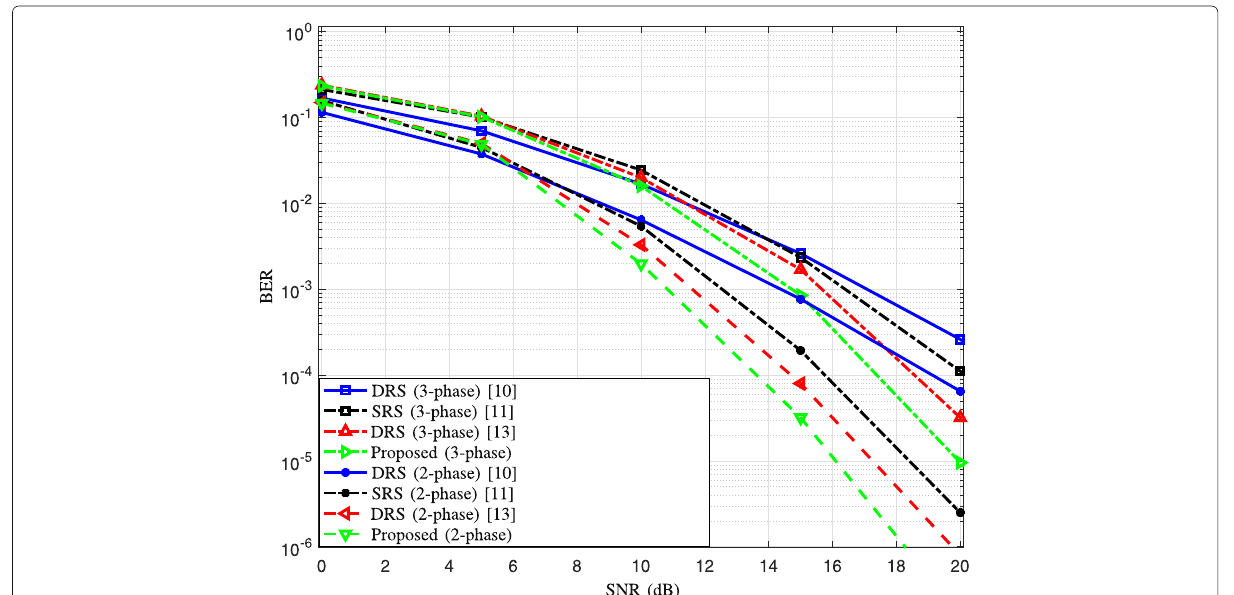
Fig. 5 BER versus SNR for several single and dual relay selection strategies using the two and three-phase relaying protocol with a rate of 1 bpcu and R =